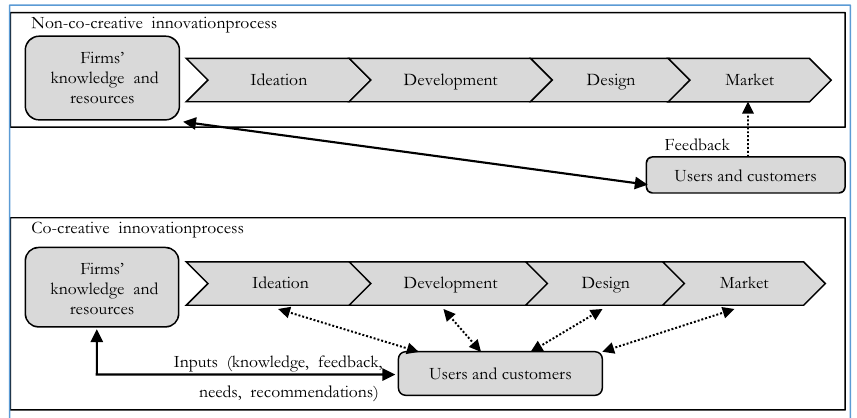
Fig. 1 A comparison of the non-co-creative and the co-creative innovation